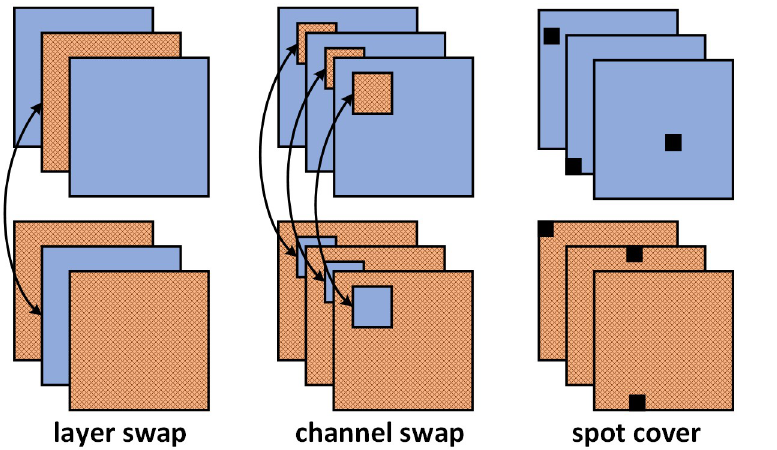
Fig 4. Feature augmentation methods within